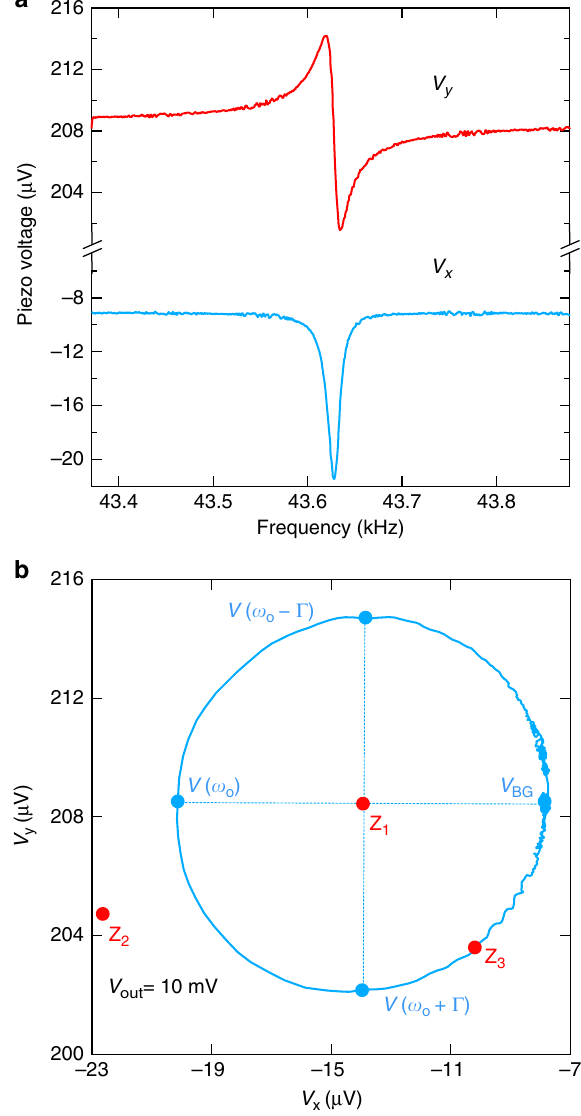
Fig. 7 Cantilever resonance. a Frequency scans through the normal mode resonance at room temperature and in air. The in-phase and out-of-phase voltages are shown in blue and red, respectively. b The Lorentzian at resonance can be observed as a circle when plotted in the complex plane. Off resonance, the background voltage V BG is measured. Approaching the resonance corresponds to tracing the circle in a counter-clockwise direction starting from V BG . The resonant frequency is observed at V ( ω o ). The positions Z 1 , Z 2 , and Z 3 in the complex plane are different possible positions of the reference point (zero voltage) from which the phase can be measured with the PLL. Depending upon the drive voltage and the capacitance compensation, the circle can be shifted to encompass, lie outside, or lie on the border of the phase reference. The effect this has on the phase swing at resonance is discussed in the text. Distortions of the circle, which are not observed in our measurements with drive voltages below 100 mV, are an indication of the nonlinear response regime of the